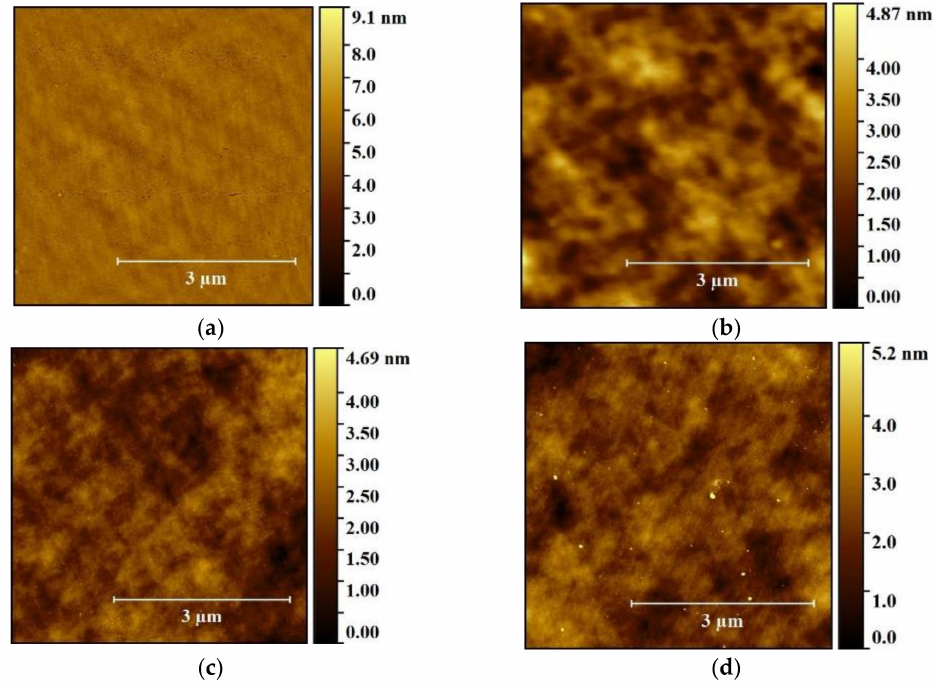
Figure 2. 5 × 5 µ m 2 2D AFM topography images of ( a ) annealed silicon wafer S0; TiO 2 thin films: ( b ) S1; ( c ) S2; ( d ) S3 sample, respectively.